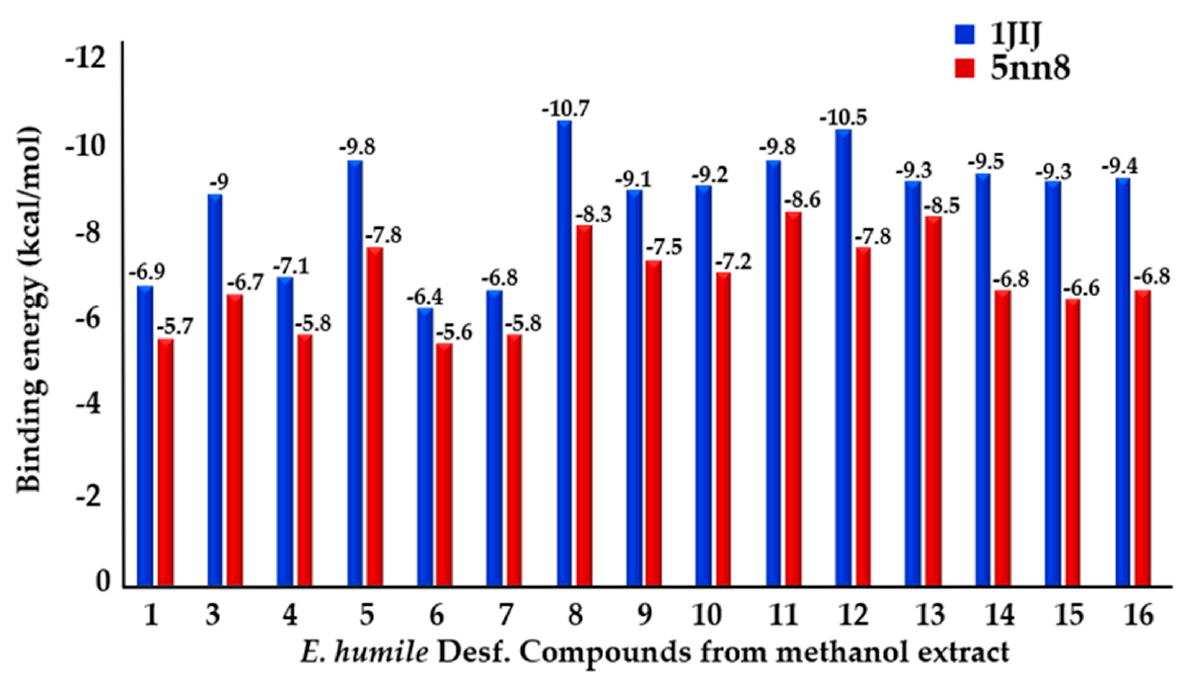
Figure 1. Binding energies of E. humile Desf. compounds complexed with TyrRS from S. aureus (PDB: 1JIJ) and human lysosomal acid- α -glucosidase (PDB: 5NN8) enzymes.